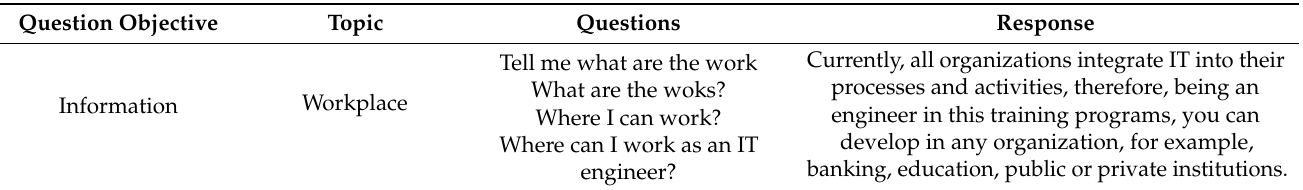
Table 2. Knowledge base structure.